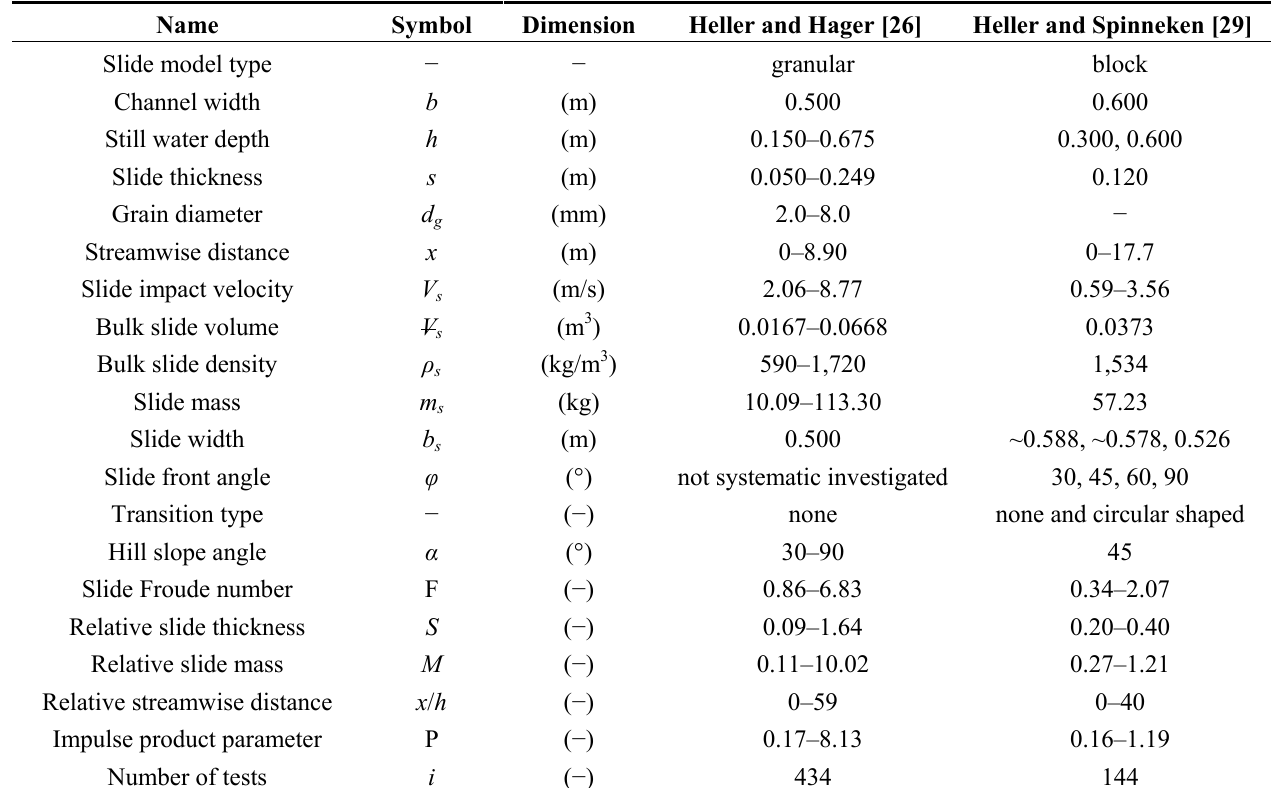
Table A1. Limitations of P: Parameter ranges of physical model studies of Heller and Hager [26] and Heller and Spinneken